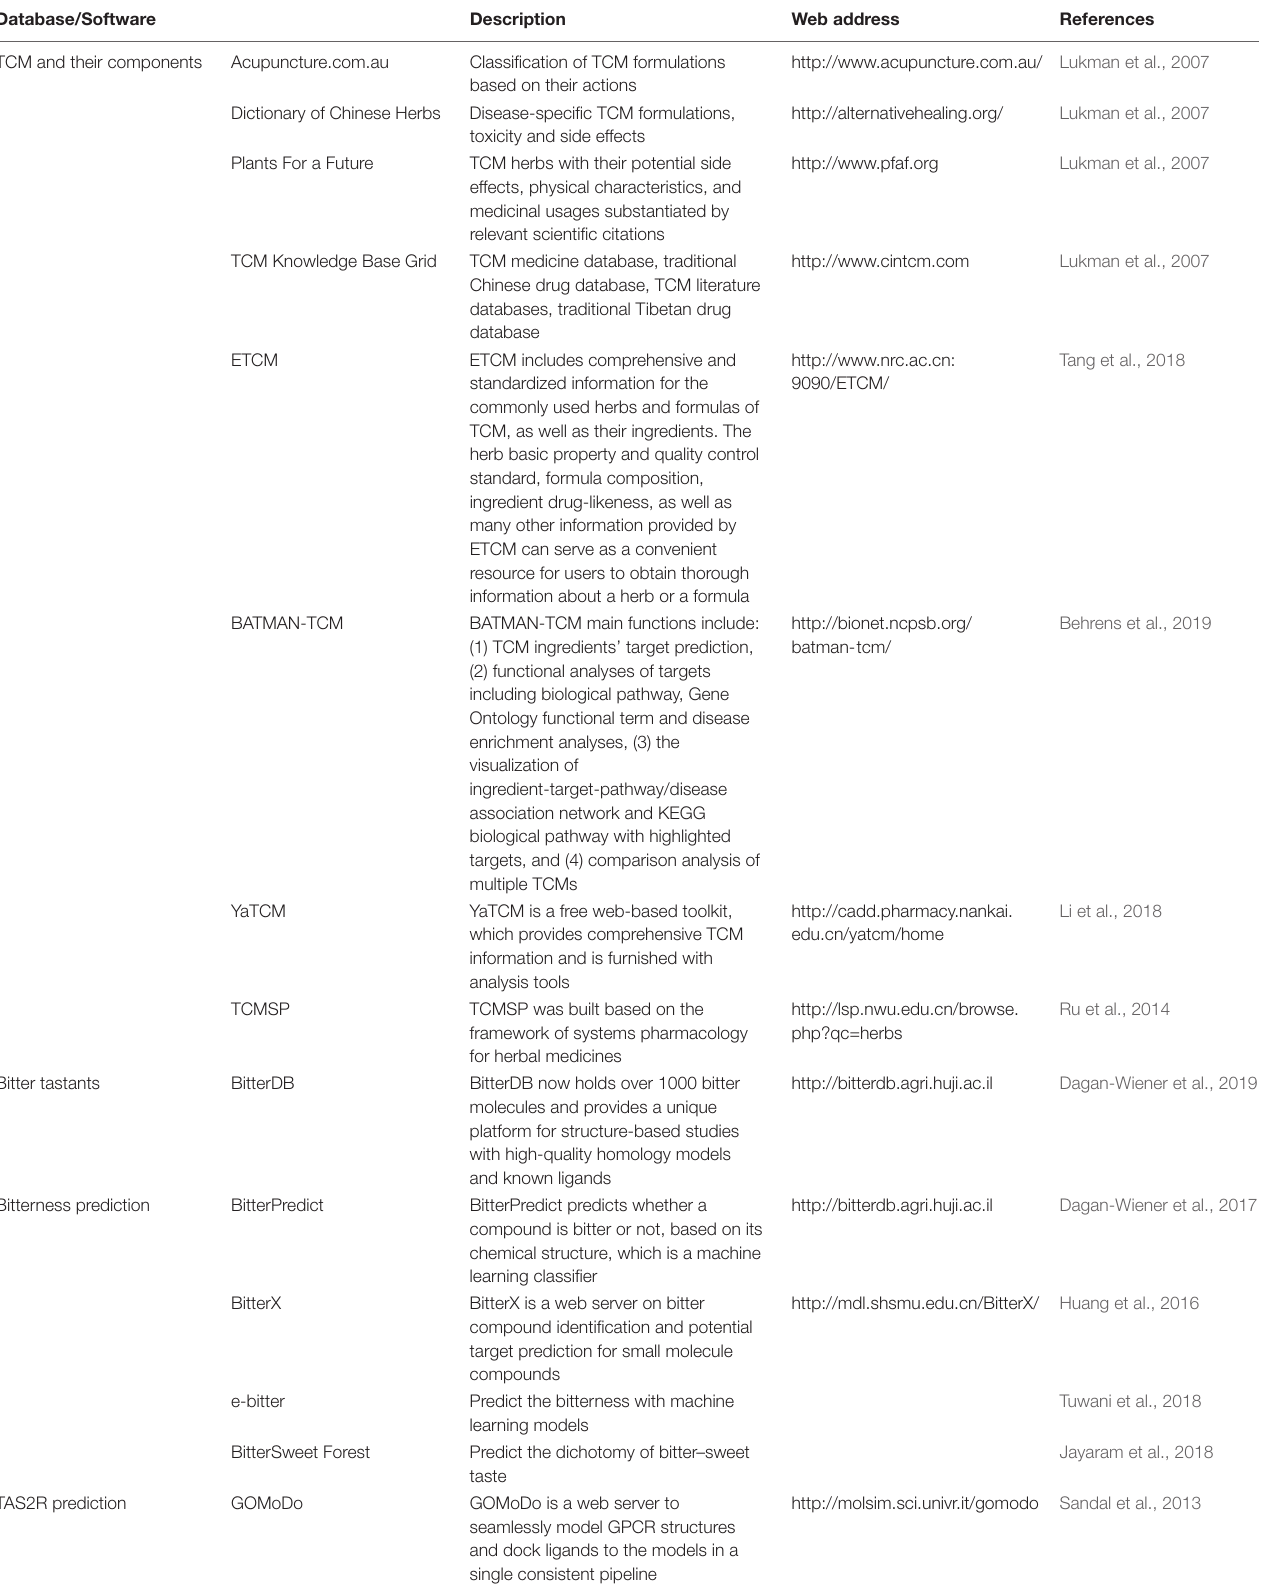
TABLE 4 | Databases and software for modern drug discovery based on bitter flavored